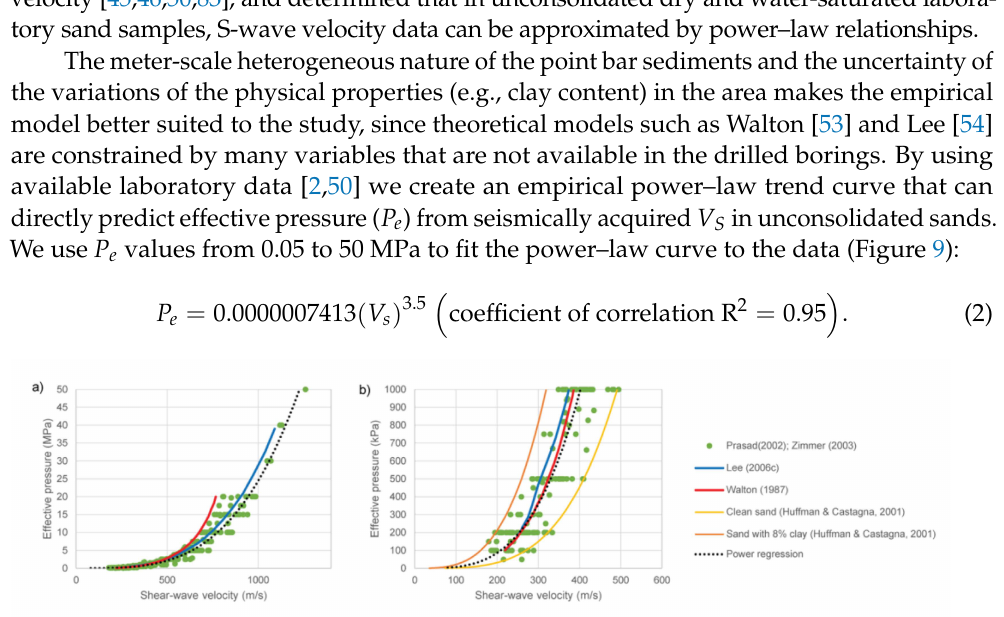
Figure 9. Effective pressure vs. shear-wave velocity plots with Walton [53] and Lee [54] theoretical models, and empirical power-curve results from Huffman and Castagna [45], which use both clean sands and sand packs that have 8% clay by weight. ( a ) A plot in MPa with the full range of laboratory data from Prasad [50] and Zimmer [2], and ( b ) a plot in kPa for the range of effective pressure and velocity of interest in this